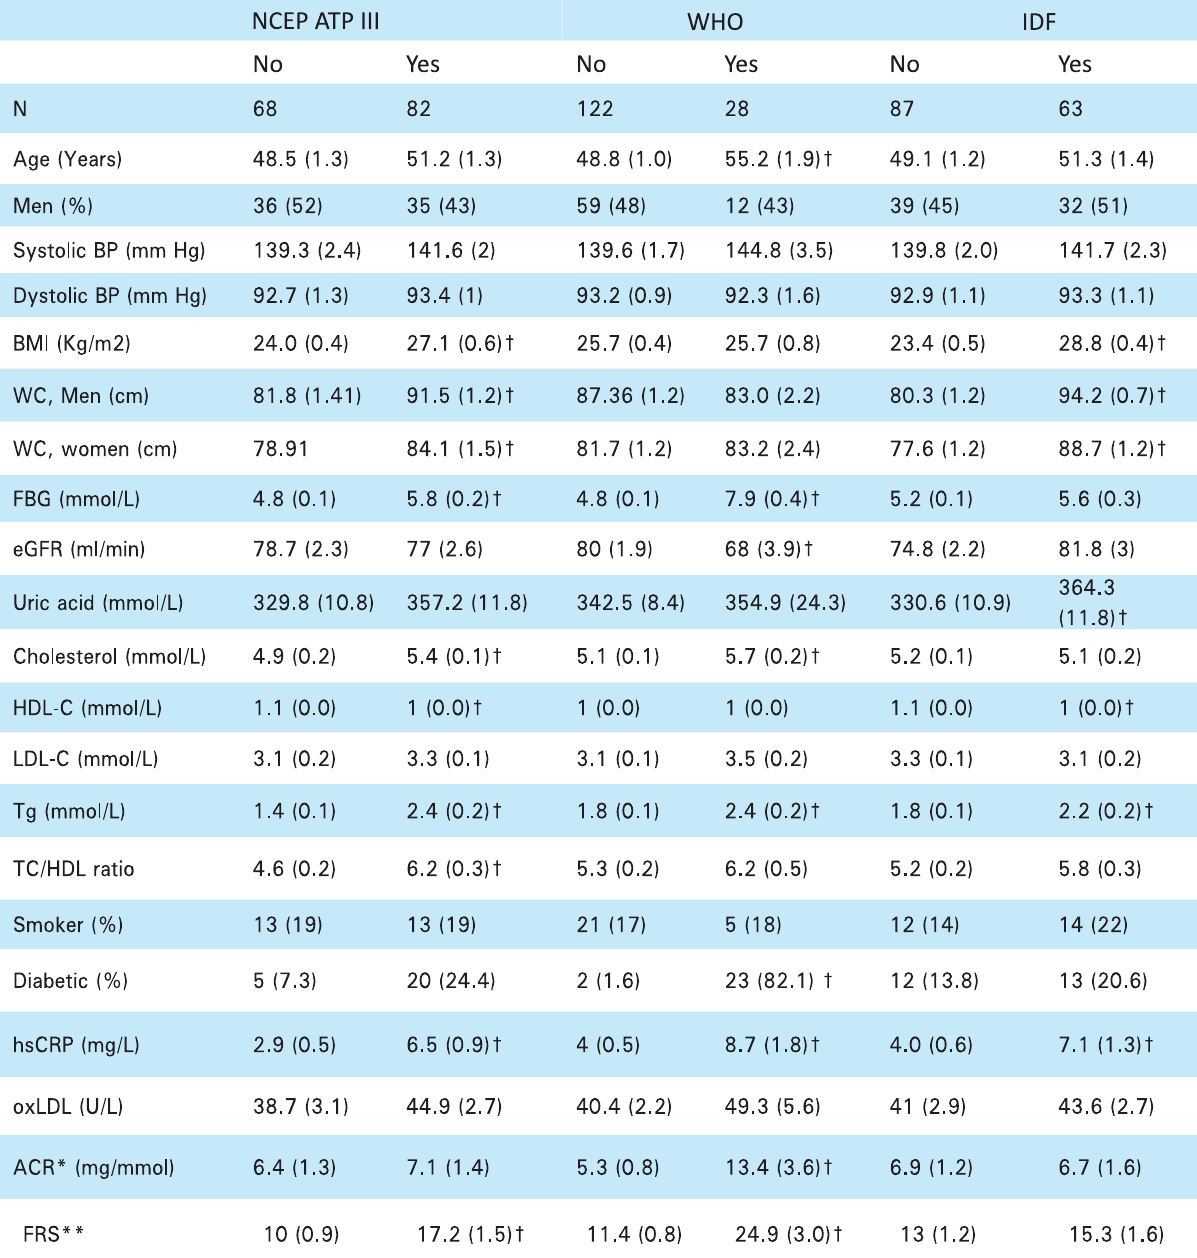
Table 2. Baseline characteristics in relation to the presence of the metabolic syndrome, by three de fi nitions (NCEP- ATPIII, WHO and